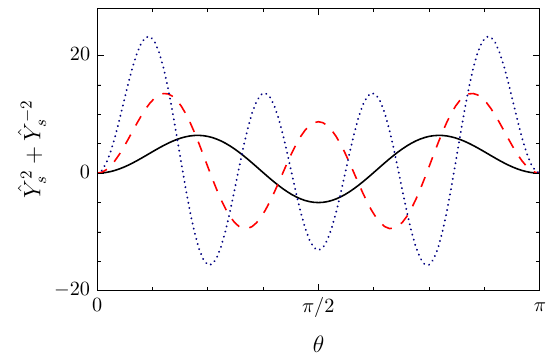
( (cid:18); 0) + ^ Y (cid:0) 2 ( (cid:18); 0) due to the exchange of a depth-1 partially s s ^ k 3 ). The solid, dashed, and dotted lines (cid:1)